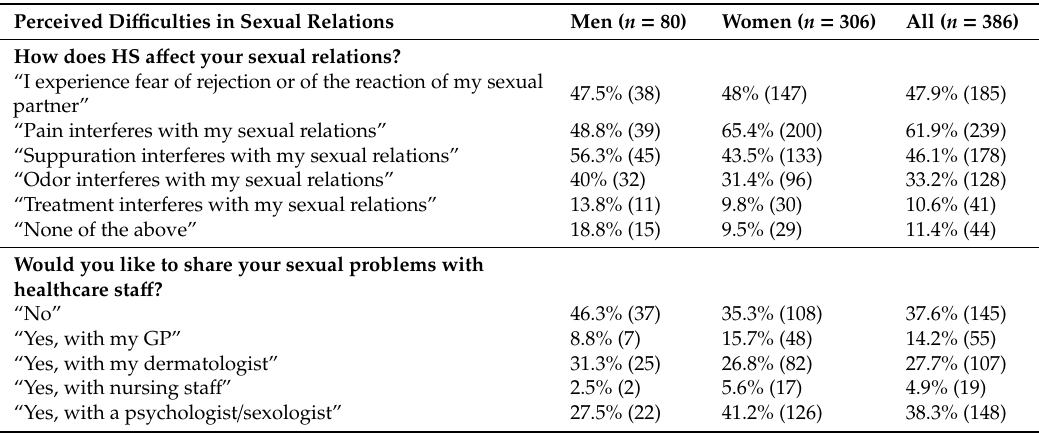
Table 2. Perceived di ffi culties in sexual relations in patients with